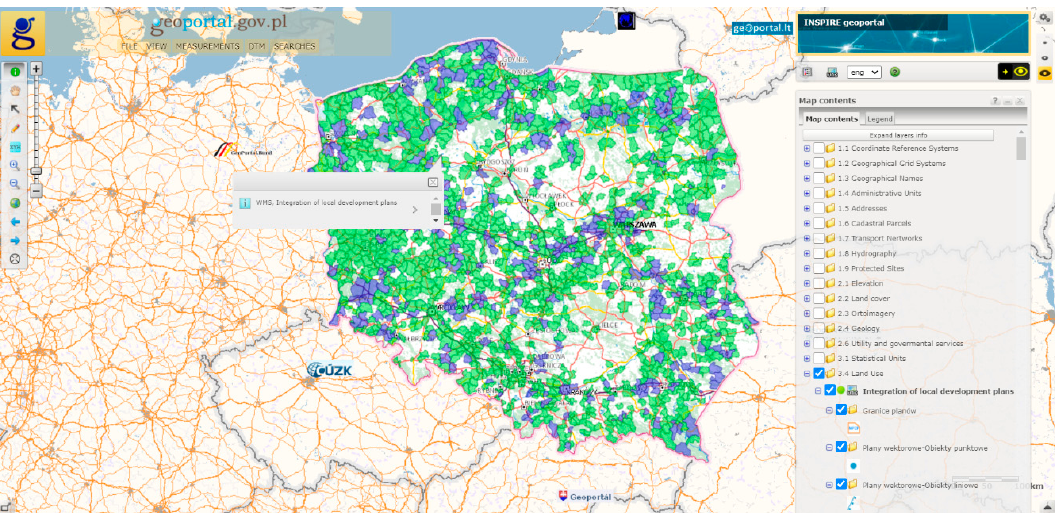
Figure 3. Geoportal 2, the portal of the Central Office of Geodesy and Cartography. Source: own study based on data from. https://mapy.geoportal.gov.pl/imap/Imgp_2.html?gpmap=gp0.